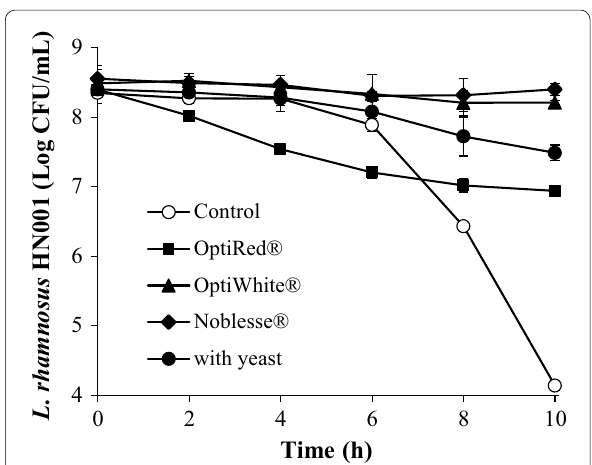
Fig. 1 Effect of yeast and IYDs on the survival of L. rhamnosus HN001 at pH 3.0. Cell counts are the mean values of triplicate experiments ( n 3), with error bars representing the standard deviation of the = mean